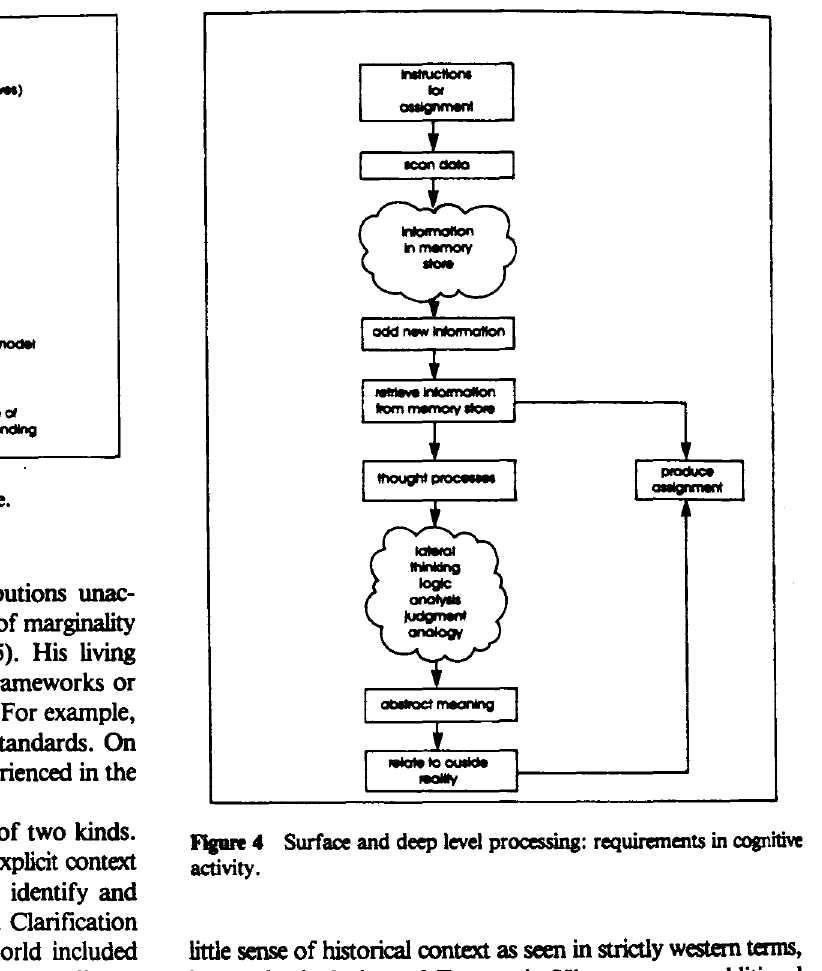
Figure 4 Surface and deep level processing: requirements in cognitive